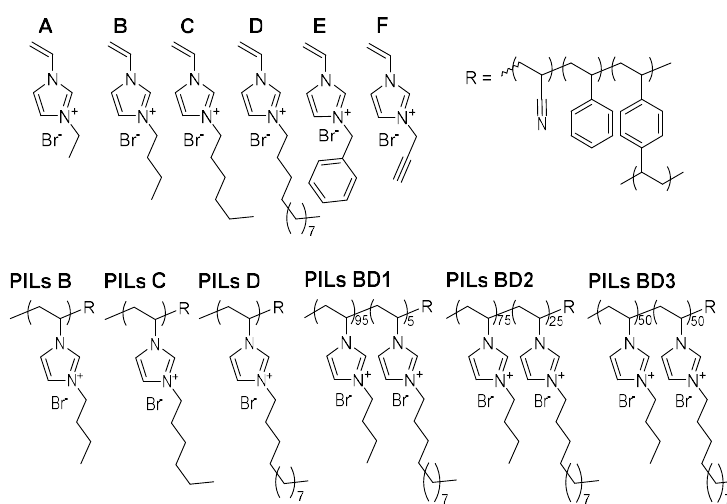
Figure 2. Ionic liquids used in membrane formation experiments and the corresponding polymers (A: [VEtIm]Br, B: [VBuIm]Br, C: [VHexIm]Br, D: [VDodecIm]Br, E: [VBnIm]Br, F: [VPrylIm]Br).